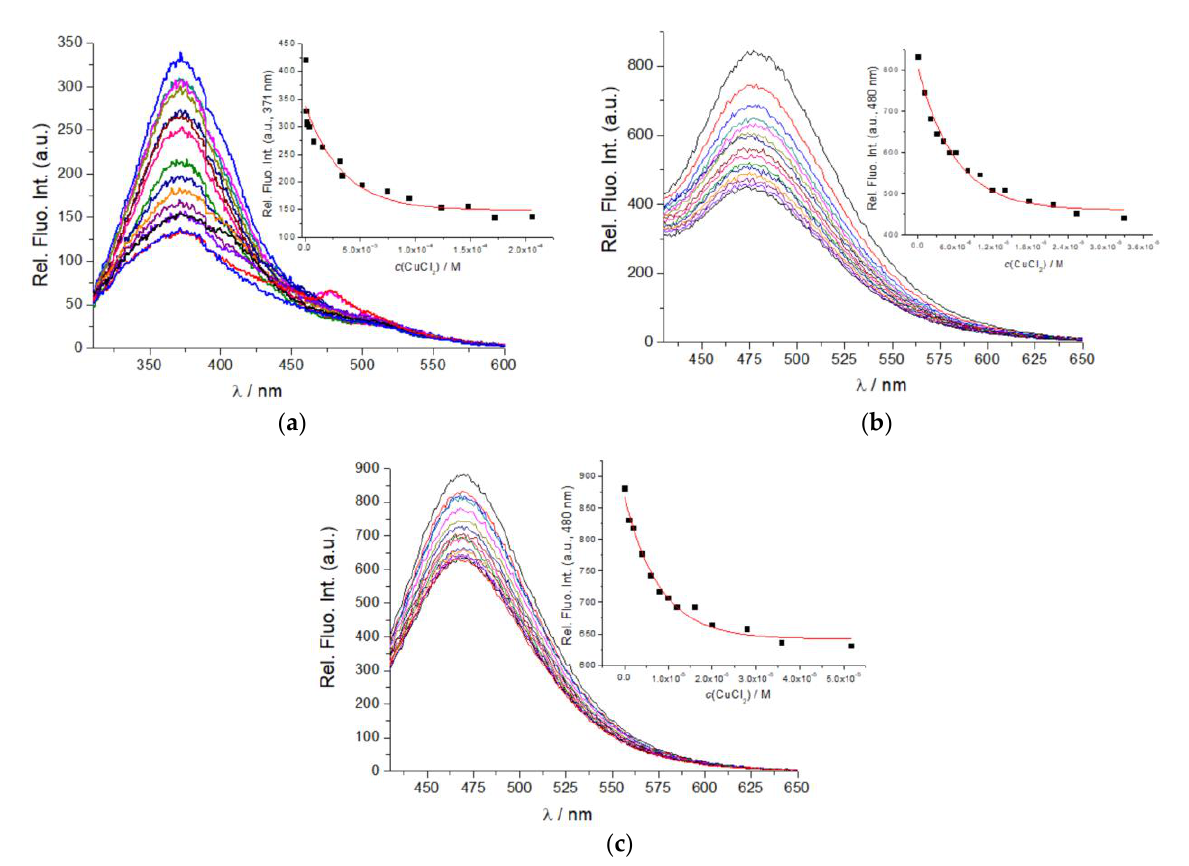
Figure 3. ( a ) Fluorimetric titration of ( a ) 10 ( c = 5 × 10 − 6 M; λ exc = 295 nm) with CuCl 2 . dependence of fluorescence at λ max = 371 nm on c (CuCl 2 ); ( b ) Fluorimetric titration of 7 ( c = 1 × 10 − 6 M; λ exc = 352 nm) with CuCl λ max = 480 nm on c (CuCl 2 , dependence of fluorescence at 2 ); ( c ) Fluorimetric titration of 6 ( c = 1 × 10 − 6 M; λ exc = 350 nm) with CuCl 2 , dependence of fluorescence at λ max = 470 nm on c (CuCl 2 ). Performed at pH = 7.0, sodium cacodylate buffer, I = 0.05 M.